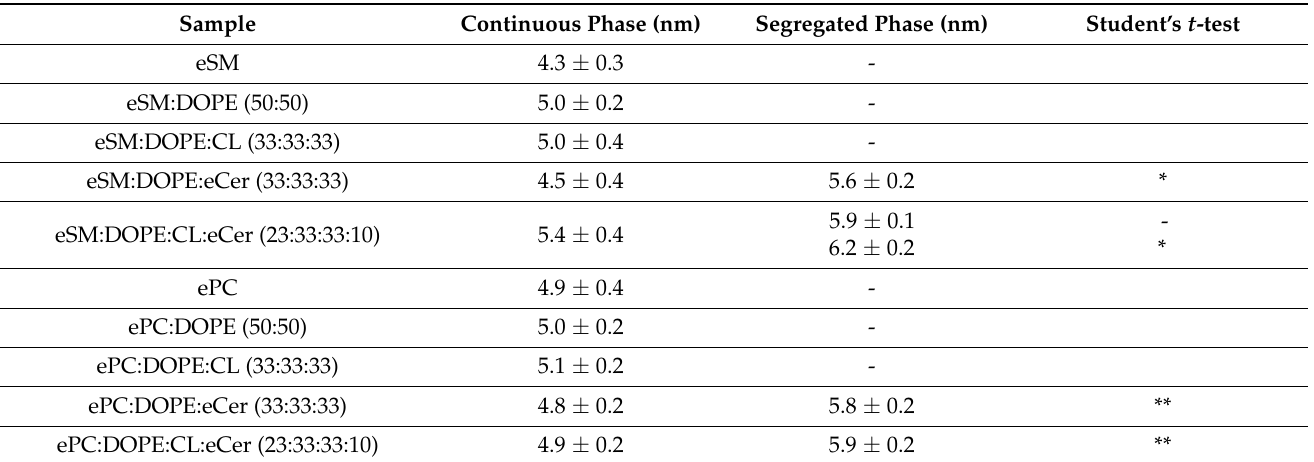
Table 2. Bilayer thickness of the different SLB under study. Data expressed as mean ± SD, n = 50.